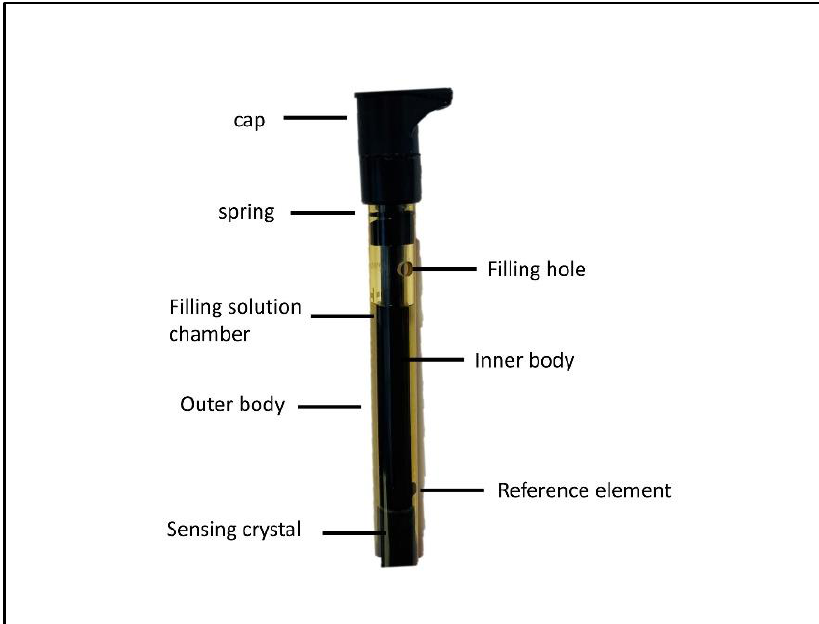
Figure 6. Fluoride selective electrode probe.